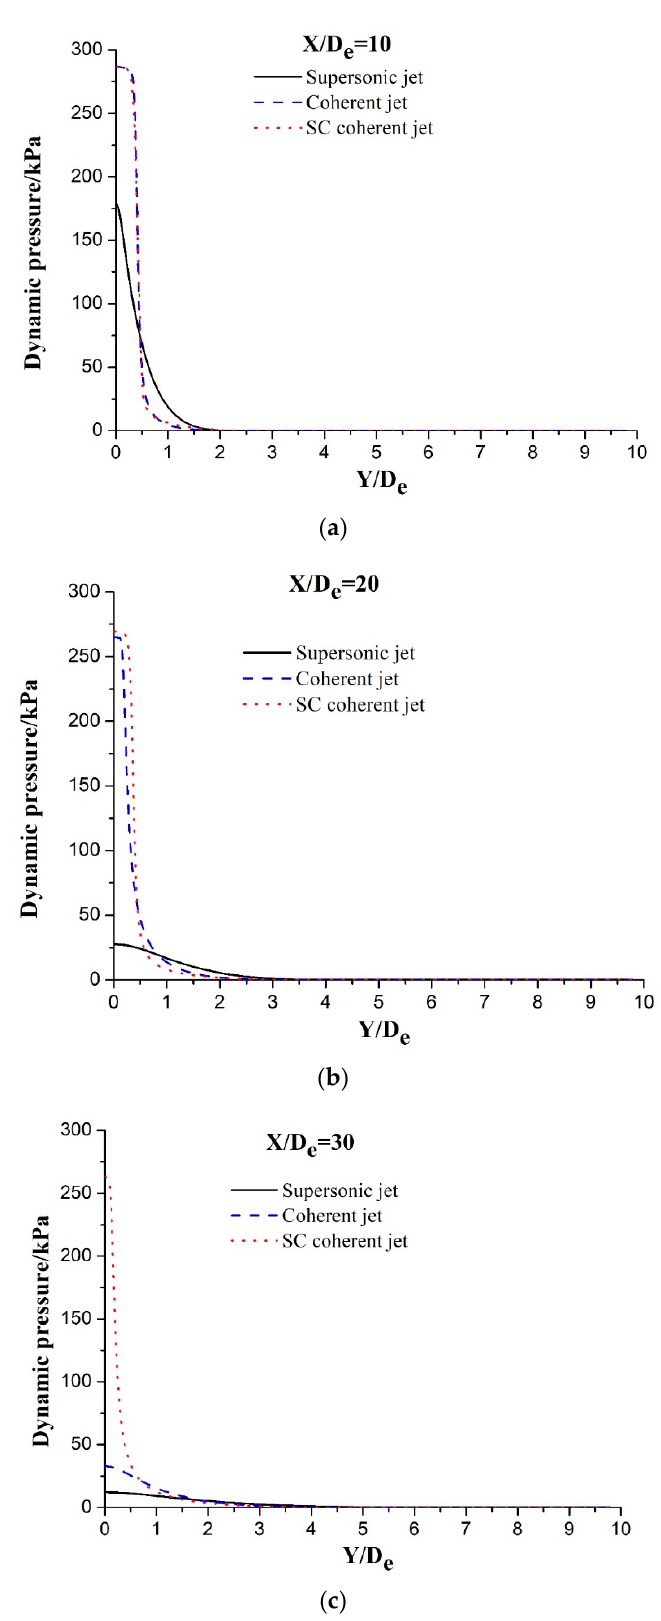
Figure 7. The radial dynamic pressure distribution at different axial locations in the case of different jets: ( a ) supersonic jet; ( b ) coherent jet; and ( c ) SC coherent jet.